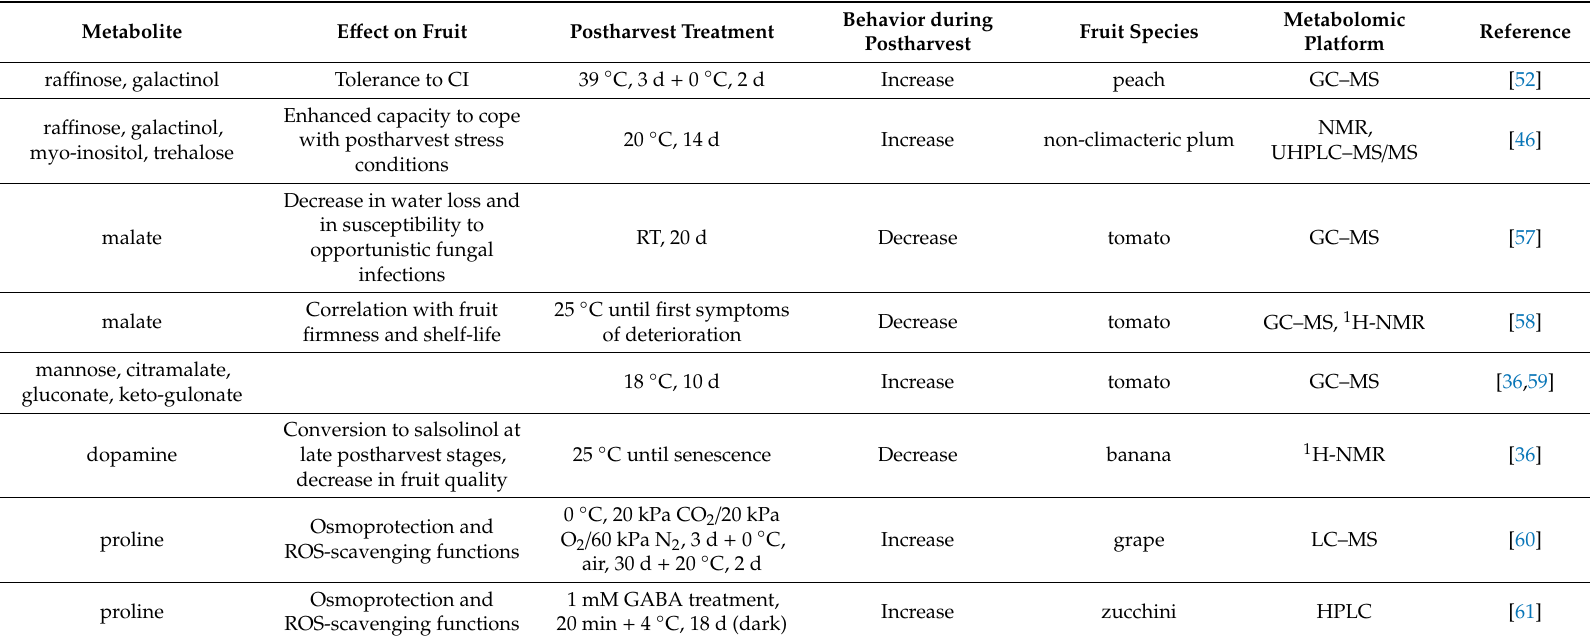
Table 1. Primary metabolites (sugars, organic and amino acids) identified as putative biomarkers by metabolomic profiling studies to assess fruit quality changes during postharvest storage. d: day; RT: room temperature; HPLC: high-performance liquid chromatography; UHPLC–MS / MS: ultra-high-pressure